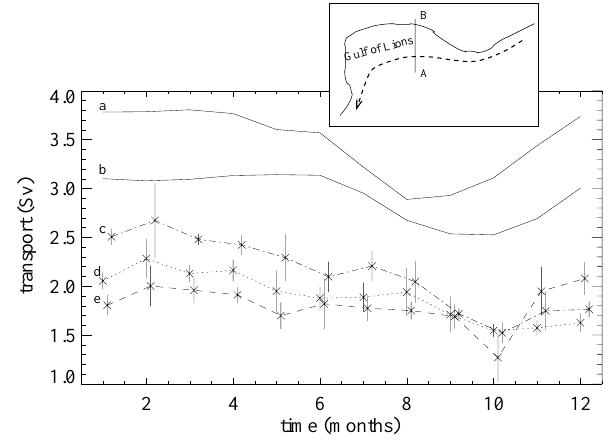
Fig. 8. Westward transport of the NC through a section (A-B) north of (5 ◦ E 42.2 ◦ N) for the GM (full line) and the RM (dotted line: year I; dashed line: year II; dash-dotted line: year III). Error bars correspond to the standard deviation of the transport calculated from 3-day-mean transport